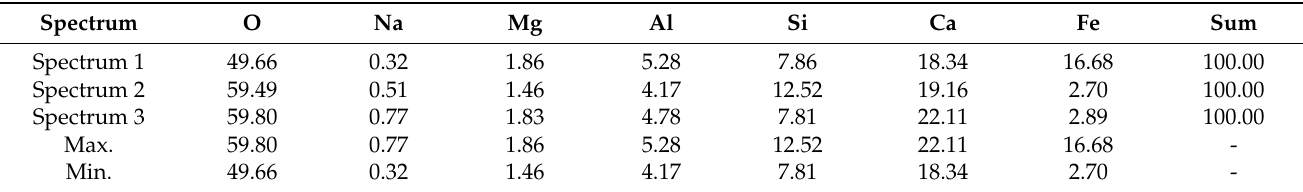
Figure 2. Electron microscopic image of the sorbent before wastewater treatment. Table 3. Composition of the sorbent before wastewater treatment. Table 3. Composition of the sorbent before wastewater treatment.